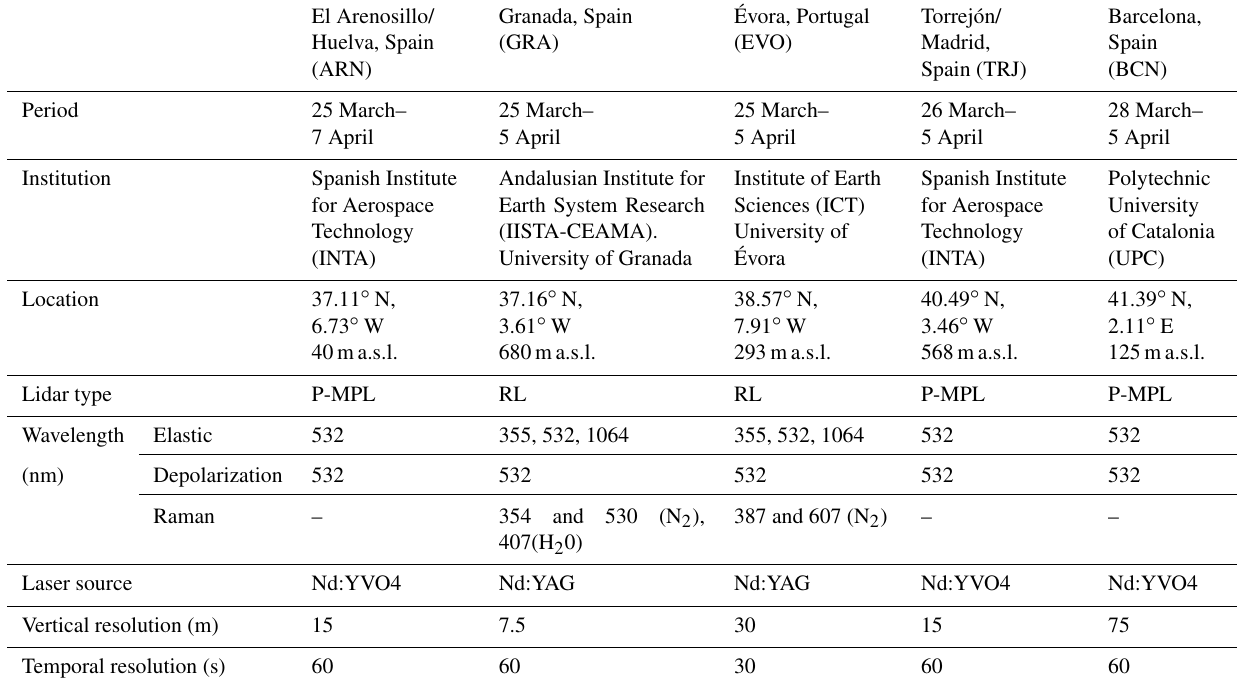
Table 1. Details of the five Iberian lidar stations used in this work and the corresponding period of the dust outbreak lasting over each one. P-MPL and RL denote polarized micro-pulse lidar and Raman lidar,